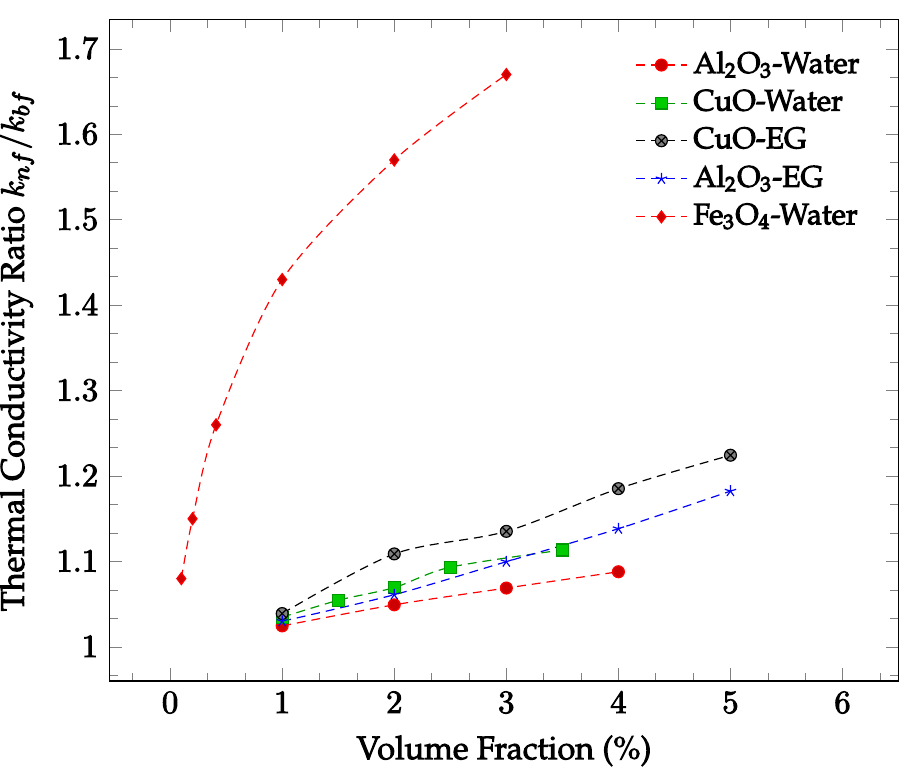
Figure 2. Dimensionless nanofluid thermal conductivity as a function of volume fraction at approxi- mately 300 K for Al 2 O 3 in water [16], Al 2 O 3 in ethylene glycol (EG) [17], CuO in water [16], CuO in ethylene glycol (EG) [18], and Fe 3 O 4 in water [19].